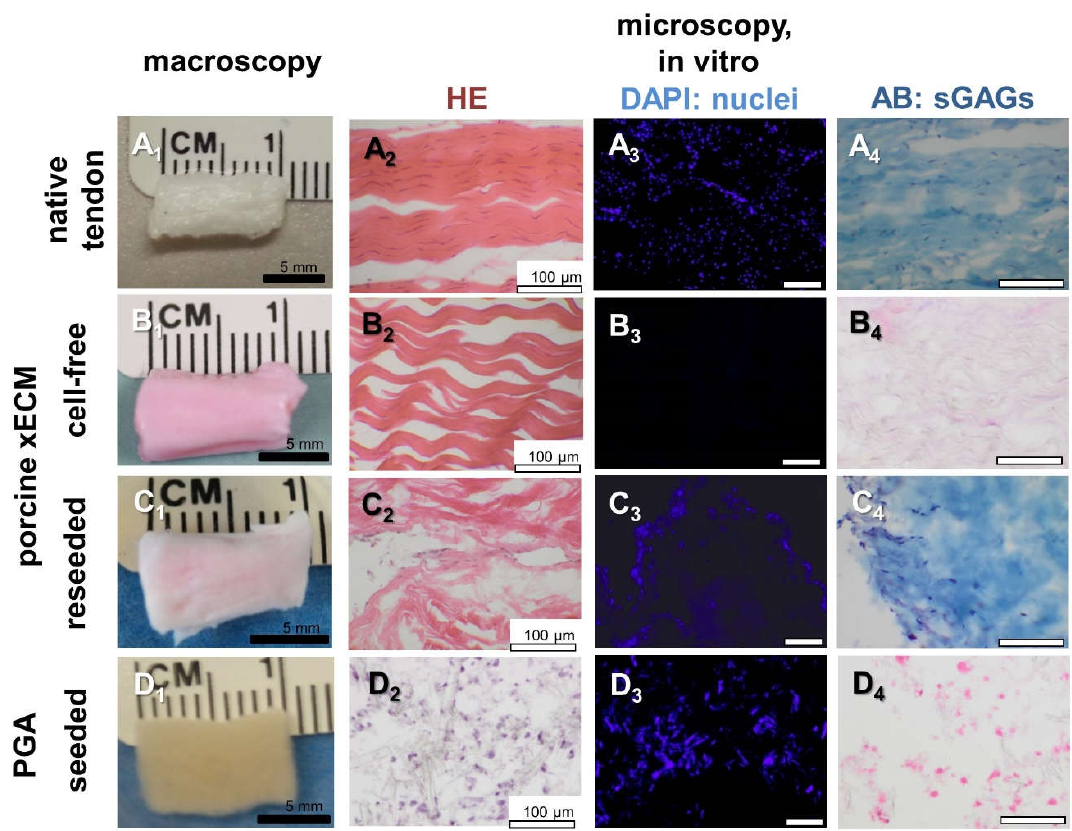
Figure 1. Macroscopical and histological appearance of native porcine AS tendon and decellularized xECM or PGA seeded or not with human tenocytes after one week in vitro. ( A 1 – D 1 ) Macroscopical images of native AS tendon, cell-free and reseeded (one week) xECM (A 1 –C 1 ) and seeded (one week) PGA (D 1 ). ( A 2 – D 2 ) HE staining. ( A 3 – D 3 ) DAPI: cell nuclei are blue. ( A 4 – D 4 ) AB staining (sGAGs: sulfated glycosaminoglycans are blue). Representative images are shown. Scale bars 5 mm (A 1 –D 1 ) and 100 μm (A 2 –D 4 ).